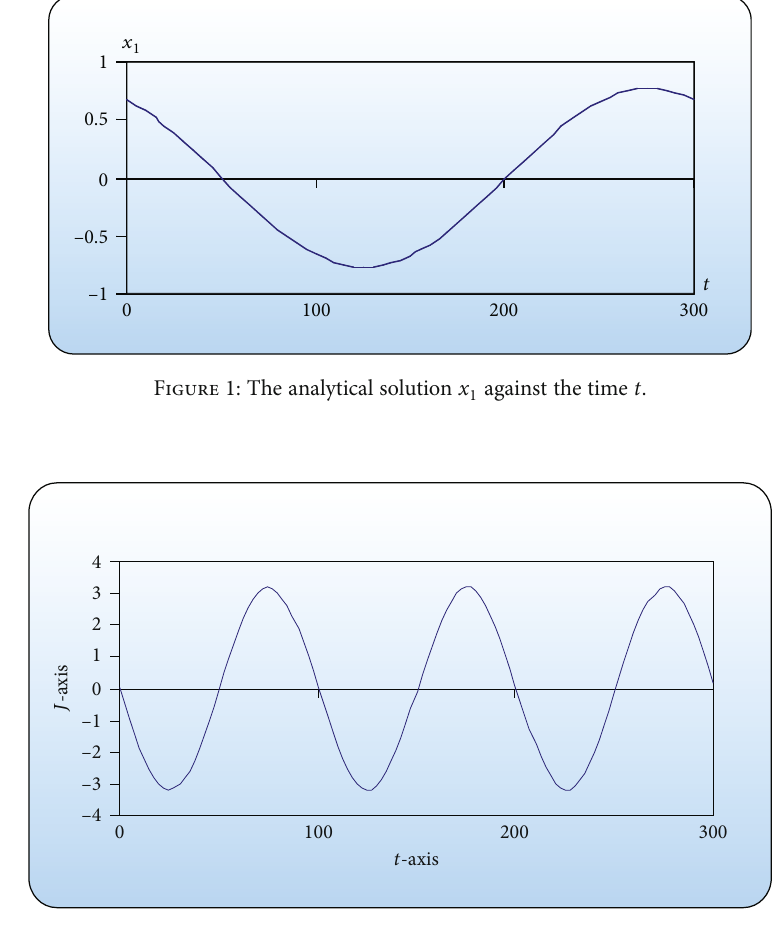
Figure 2: The analytical solution J = x